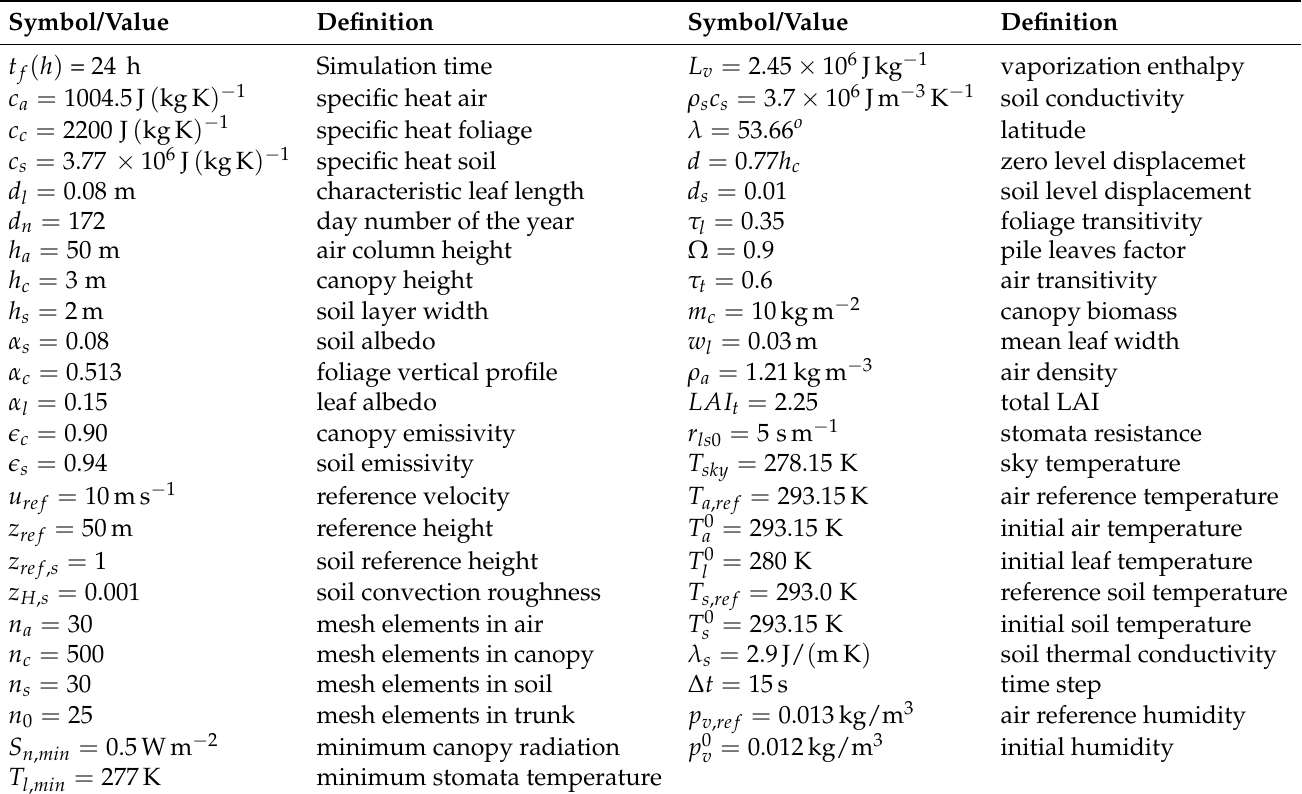
Table A1. Paremeter values used in the numerical